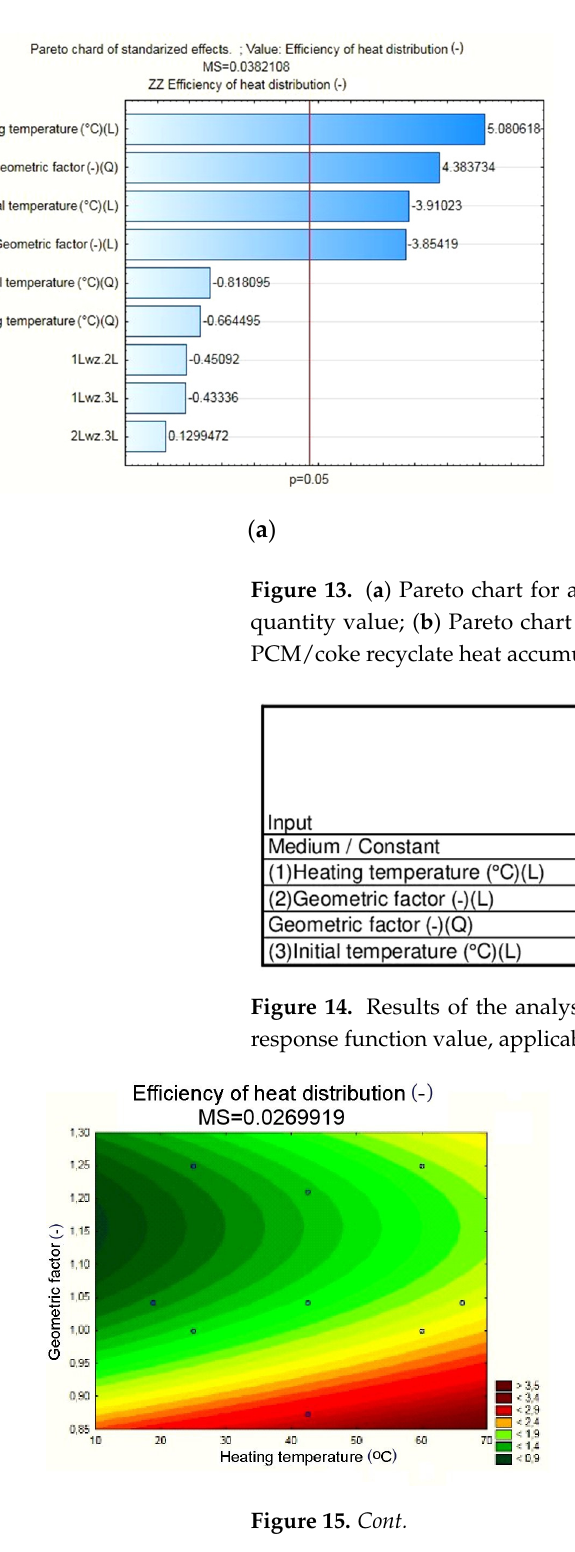
Figure 15. Response planes of the assumed polynomial approximation, presenting the impact of input quantities on the output quantity, applicable to the PCM/coke recyclate heat accumulator. 3.3.3. PCM/Copper Conductor Heat Accumulator The results of the statistical analysis for the PCM/copper conductor heat accumulators proved, as shown in Figure 16a, that the statistically significant input quantities were the heating temperature, the heating temperature correlation, and the initial temperature of the test specimens. In the next step, the statistically insignificant input variables and their correlations were included in the error component. For the separated, statistically significant input components, the results are presented as follows: the Pareto chart in Figure 16b; the analysis in Figure 17; and the response plane in Figure 18.